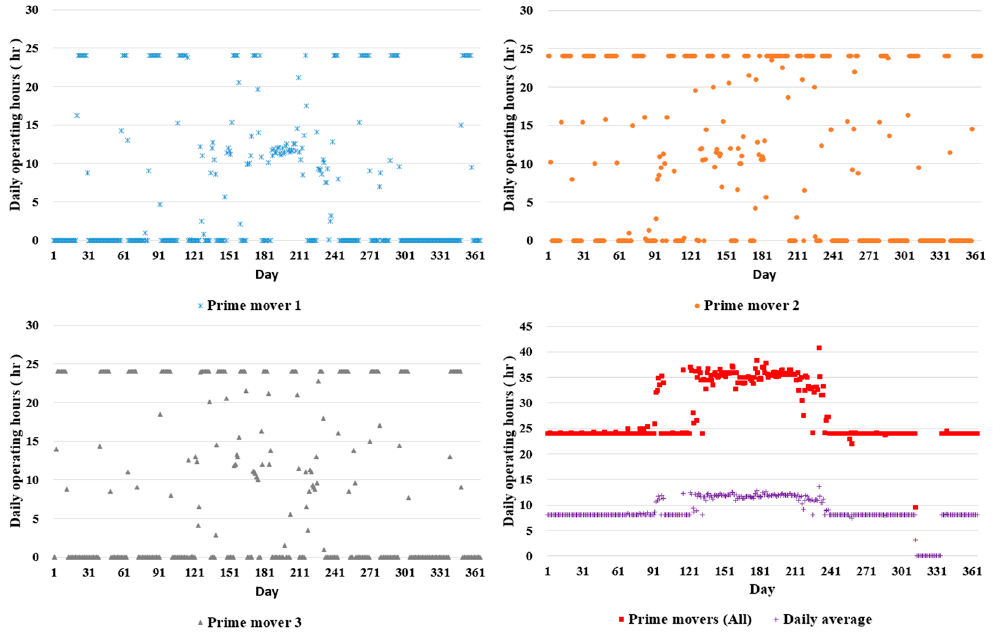
Figure 13. Annual daily operation hours of prime movers for Case C.